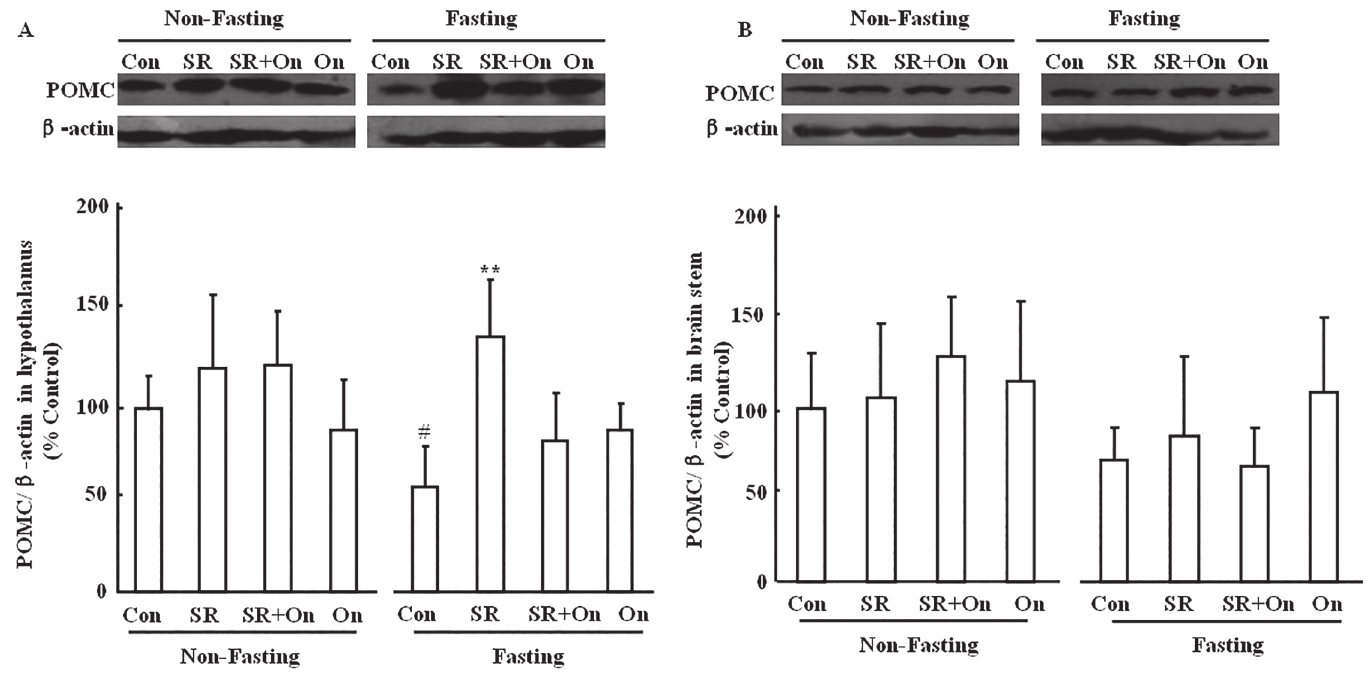
Fig 5. POMC/ β -actin ratio,normalized to control, in hypothalamus and bran stem of fed and fasted mice. Con: control group; SR: SR 57227 (10 mg/kg, i.p.); On: ondansetron (3 mg/kg, i.p.). POMC: Pro-opiomelanocortin. Values are means ± SEM (n = 8 – 10). #, P < 0.05 vs. non-fasting control group; ** , P < 0.01 vs. fasting control